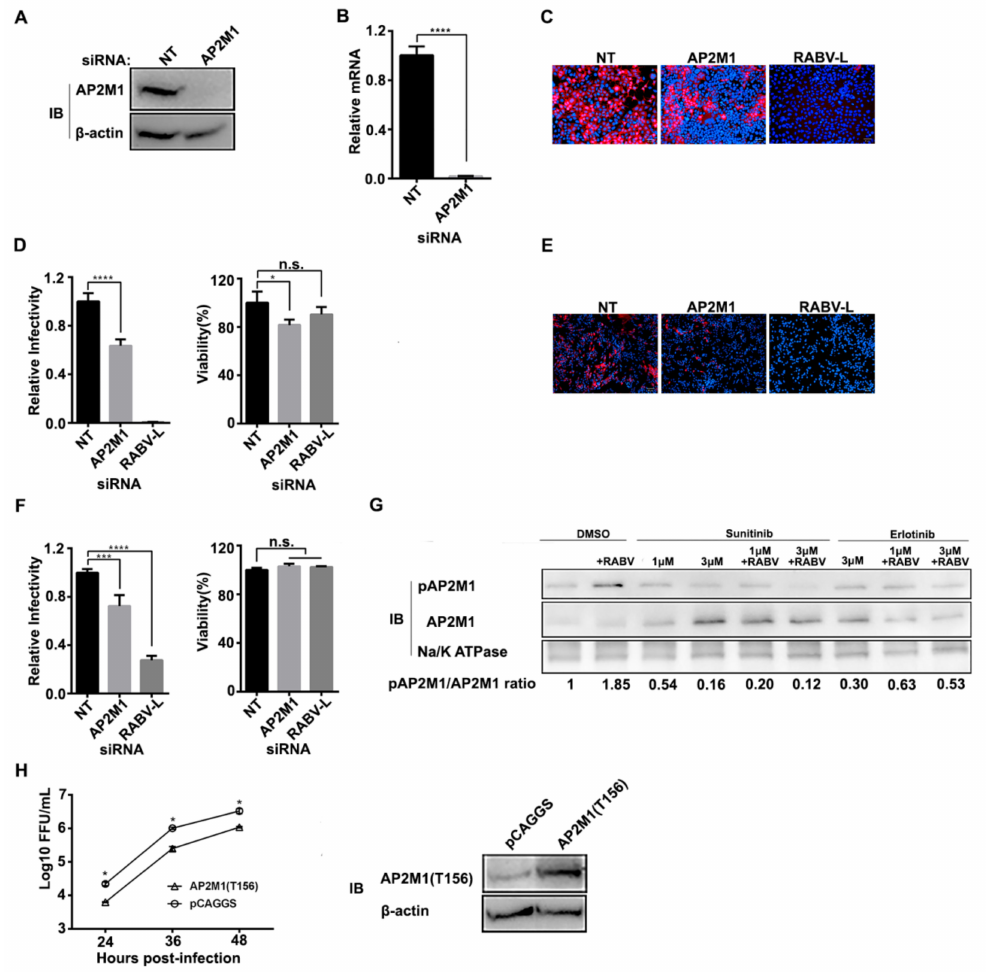
Figure 3. AP2M1 and its phosphorylation are important for RABV infection. ( A ) HEK293 cells were transfected with siRNAs AP2M1 or NT. AP2M1 expression level was determined by Western blotting. β -actin was used as a loading control. ( B ) mRNA levels of AP2M1 were determined by qRT-PCR in cells followed by siRNA transfection. A t-test was used for the statistical analysis. ****, p < 0.0001. Representative images of ERA-mCherry-infected (MOI = 0.01) HEK-293 cells ( C ) and SK cells ( E ) transfected with siRNAs targeting either AP2M1 or RABV-L, or the NT sequence. A high-content quantitative image-based analysis was used to measure the relative infection ratio (normalized to NT siRNA-treated cells) of RABV in either HEK-293 cells ( D ) or SK cells ( F ) transfected with the indicated siRNAs. Cell viability was measured at 48 h post-transfection by using the CellTiter-Glo reagent. Data are relative fluorescence values normalized to the level of the NT control. Values represent the mean ± SD. A one-way ANOVA was used for the statistical analysis. **, p < 0.01, ***, p < 0.001, ****, p < 0.0001; n.s., not significant. ( G ) HEK-293 cells were treated with various concentrations of sunitinib or erlotinib for 1 h at 37 ◦ C before infection of ERA-mCherry at an MOI of 10, and then incubated for 1 h on ice to allow attachment of viral particles to cell surface receptors. Then the residual viruses were removed, and cell plasma membrane proteins were isolated to detect the phosphorylation of AP2M1 by Western blotting. ( H ) HEK-293 cells were transfected with pCAGGS-AP2M1(T156A) or pCAGGS. At 48 h post-transfection, the cells were infected with ERA-mCherry (MOI = 0.05), and virus titers were determined as focus forming units (FFU) in BSR-T7 / 5 cells. Multiple t-tests were used for the statistical analysis, *, p < 0.05. AP2M1-T156 overexpression was confirmed by Western blotting (right